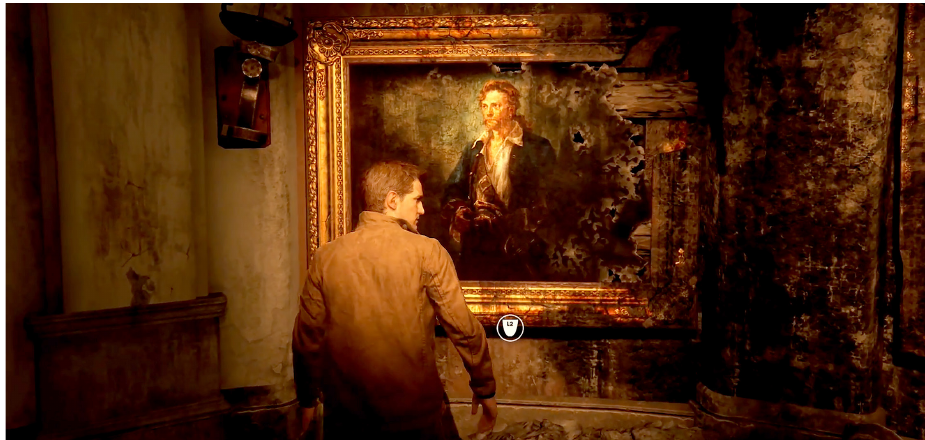
Fig. 1 Uncharted